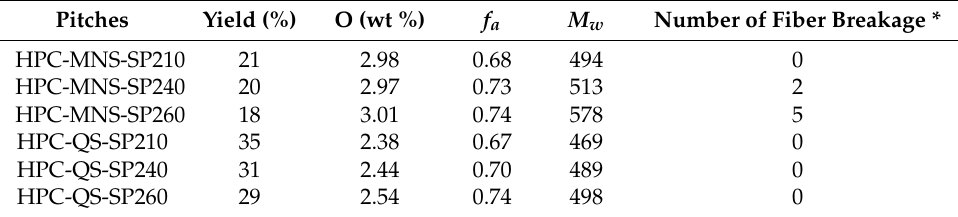
Table 2. Properties of the prepared pitches.